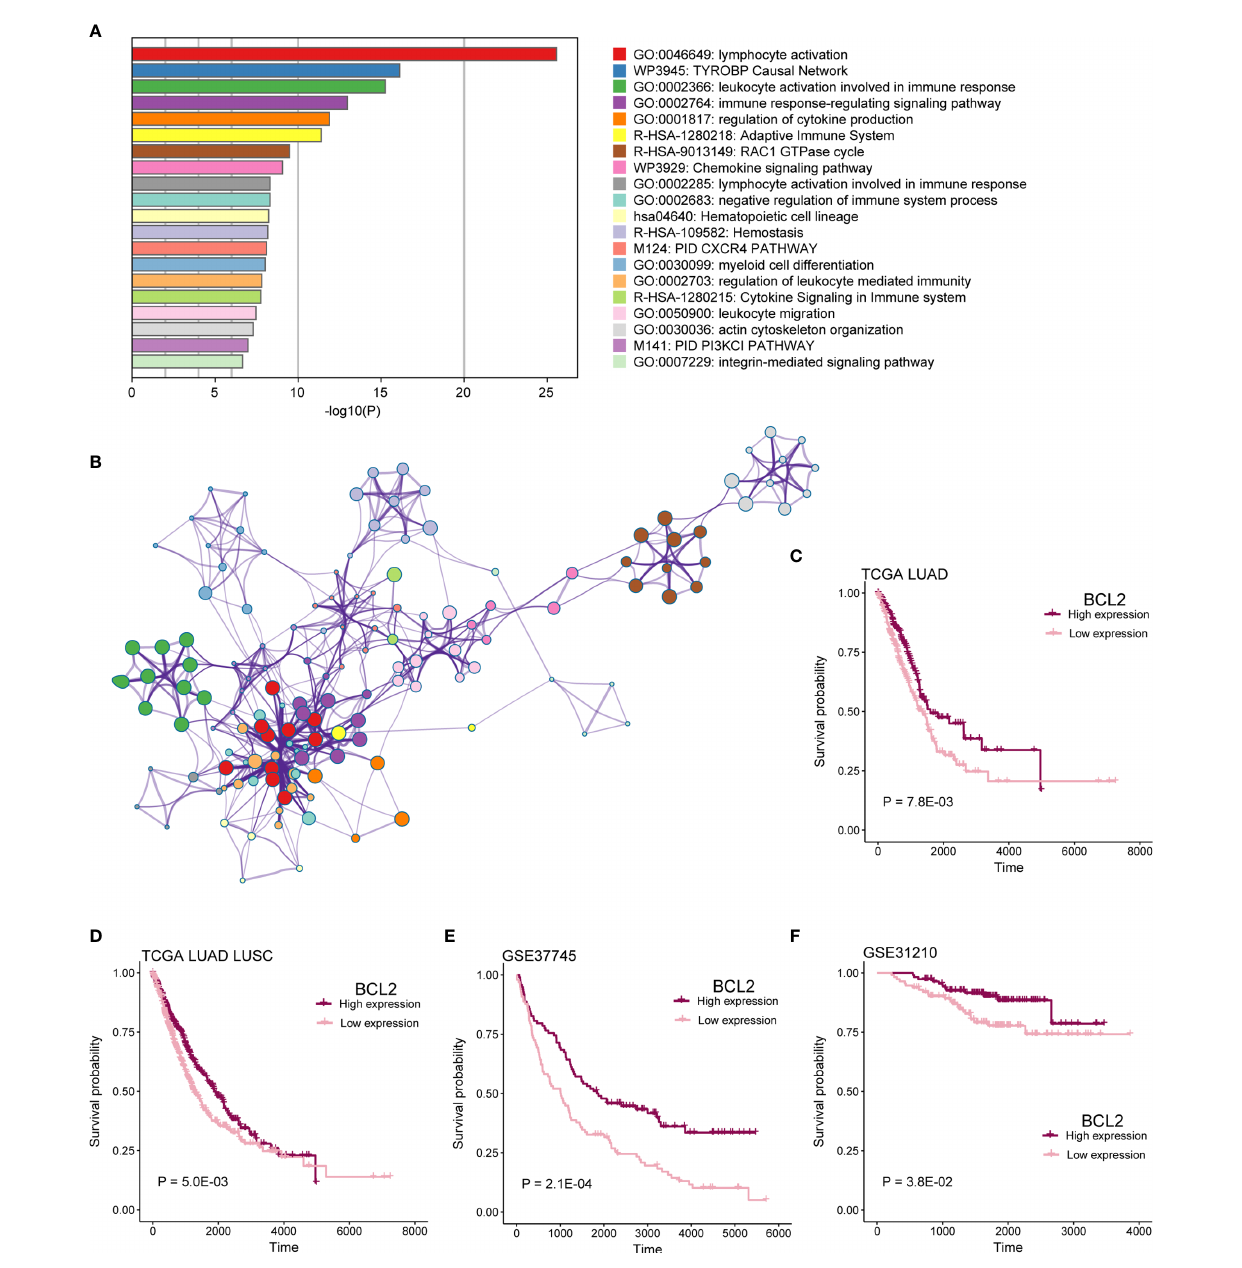
FIGURE 8 | mRNAs in co-expression network functional analysis. (A) Enrichment analysis for 16-lncRNAs signi fi cant co-expression 225 mRNAs. The graphical representation showed top 20 enrichments with P < 0.01. P value was multi-test – adjusted in log base 10. (B) Enriched terms with a similarity > 0.3 are connected by edges. (C – F) Survival analysis showed the difference in OS between BCL2 high expression and low expression samples in TCGA LUAD, TCGA lung cancer, GSE37745, and GSE31210